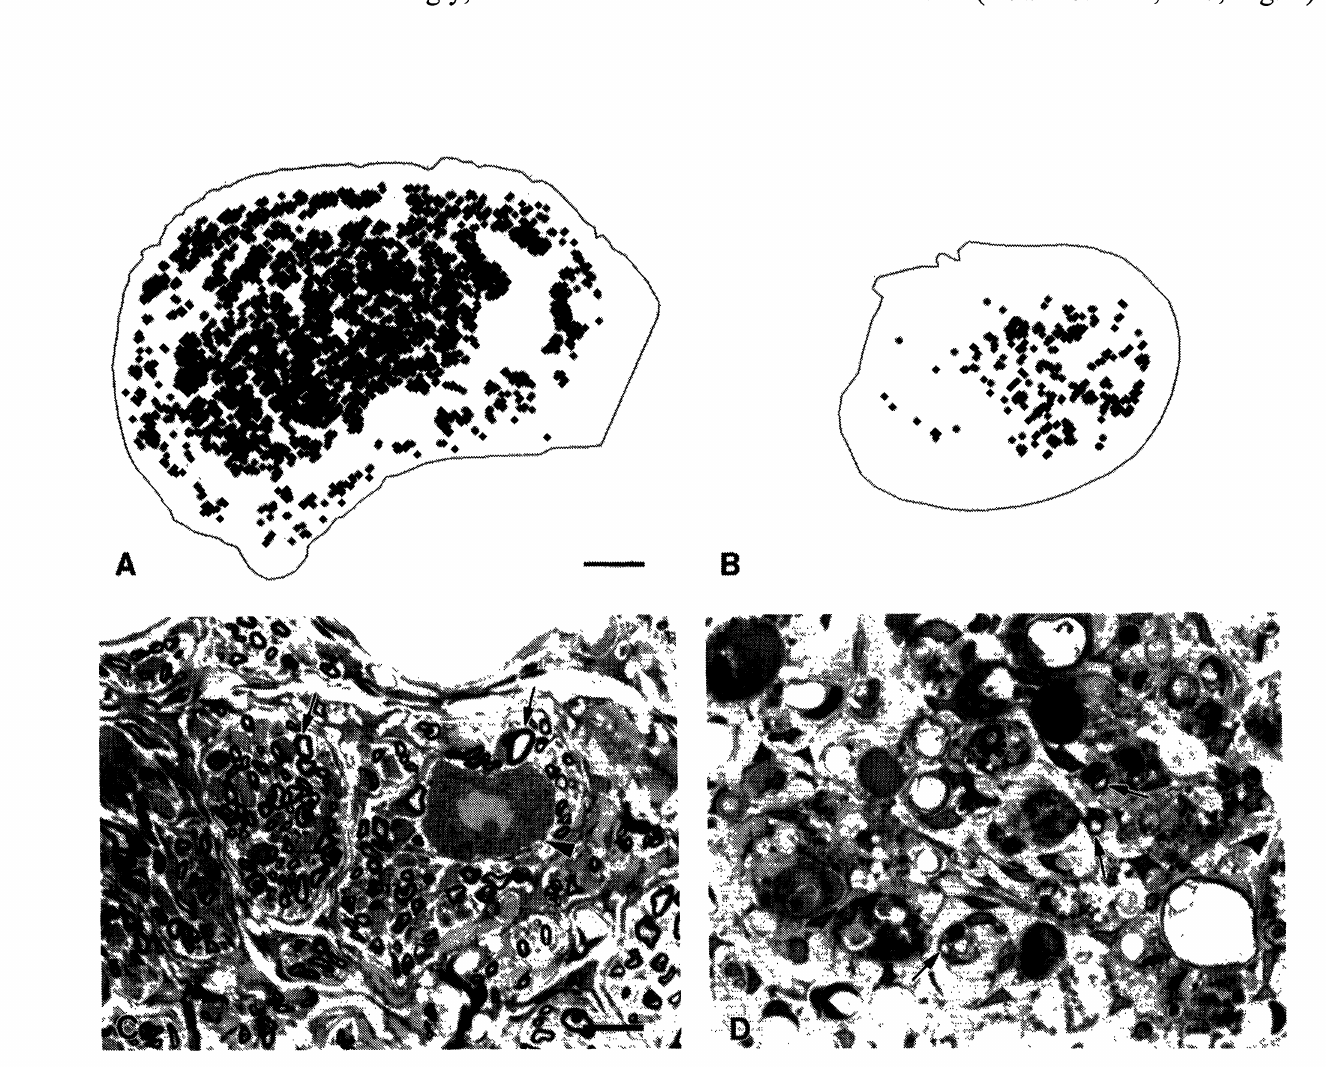
Fig. 4: A-B" Representative Neurolucida plots of myelinated axonal profiles taken from toluidine blue stained ltm semi-thin plastic cross sections of a FSC graft (A) and a freeze-thaw control graft (B). Each diamond represents a cross sectional profile of a myelinated axon. C-D High power photomicrographs of a FSC graft (C) and a freeze/thaw control graft (D). Within the FSC graft, many myelinated axons are found (C, arrows). Occasionally, neuron-like cells (C, arrowheads) are seen within the FSC graft. Note only a few axon profiles are present in the freeze-thaw control graft (D, arrows). Bars: A-B, 100tm; C-D,